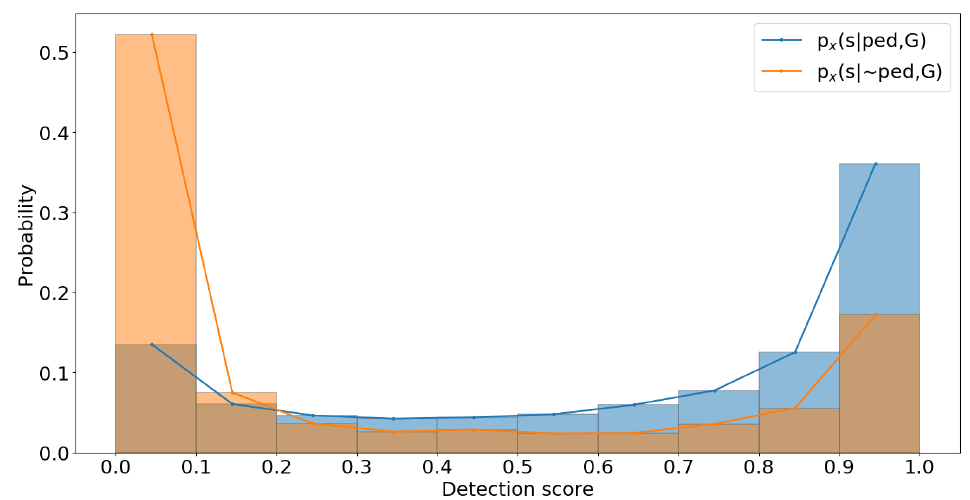
Figure 3. Likelihood histograms from a dataset category: likelihood for true positives- p x ( s | ped , G ) and false positives- p x ( s | ∼ ped , G ) .